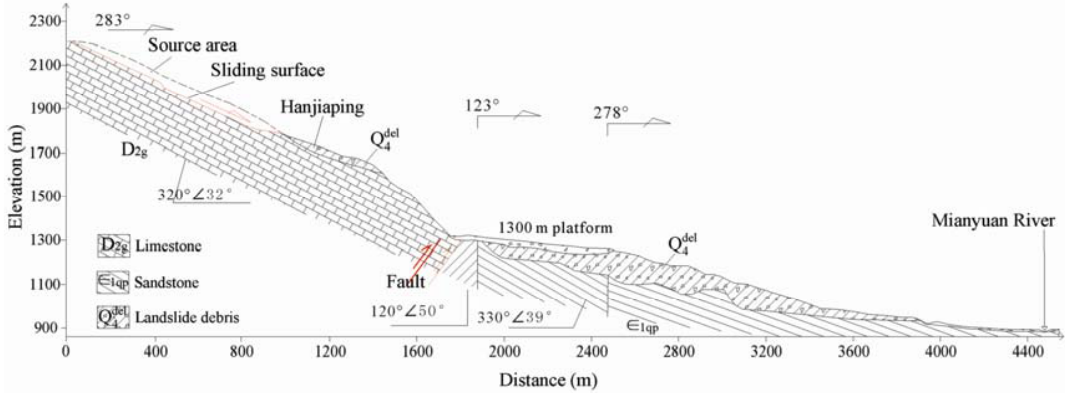
Fig. 5. Section of the Wenjia gully landslide (Huang and Zhao, 2010).